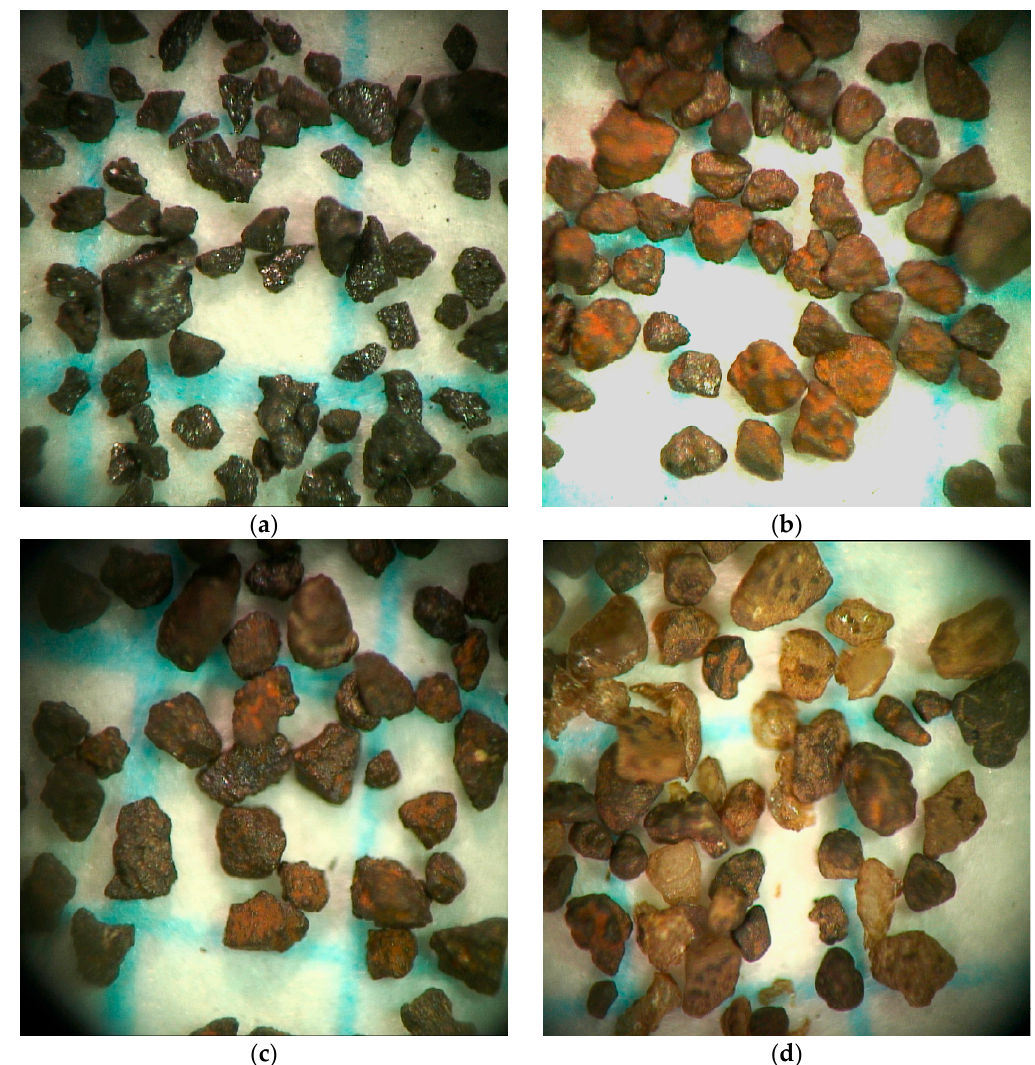
Figure 9. High-resolution light microscope pictures of fresh manganese ore and three bed samples extracted during operation. The blue squares has a side measuring 1 mm. Note that the particles in Figure 9d was extracted after the research campaign had been finished, during the replacement of ore with sand by plant personnel. ( a ) Fresh manganese ore; ( b ) 100% Mn ore after 20 h of operation; ( c ) 100% Mn ore after 172 h of operation; and ( d ) after >300 h of operation (mixed with